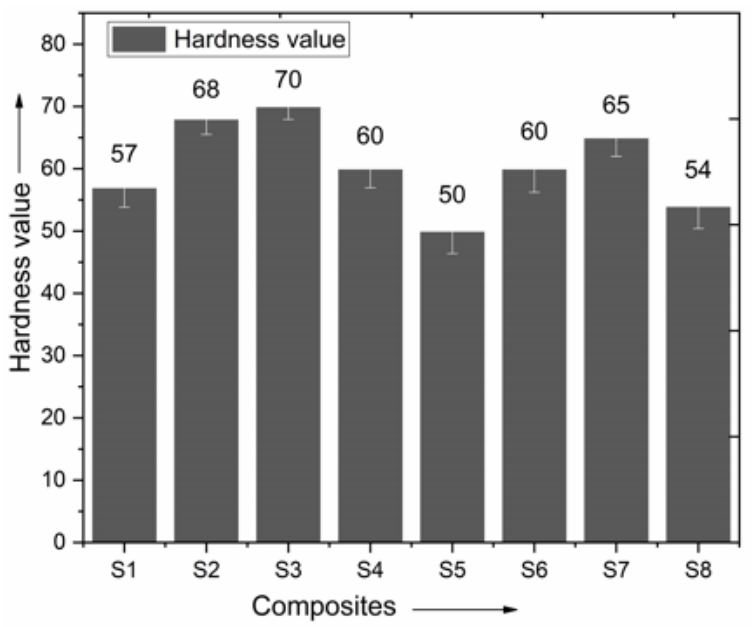
Figure 13. Comparison of